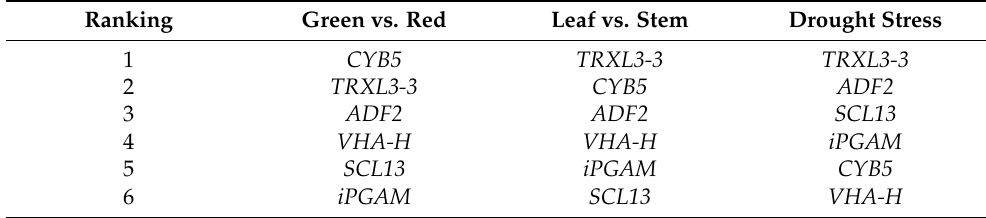
Table 4. Comprehensive stability ranking of six candidate reference genes (RGs) for three different experiments: green vs. red, leaf vs. stem, and drought stress. Ranking Green vs. Red Leaf vs. Stem Drought Stress 1 CYB5 TRXL3-3 TRXL3-3 2 TRXL3-3 CYB5 ADF2 3 ADF2 ADF2 SCL13 4 VHA-H VHA-H iPGAM 5 SCL13 iPGAM CYB5 6 iPGAM SCL13